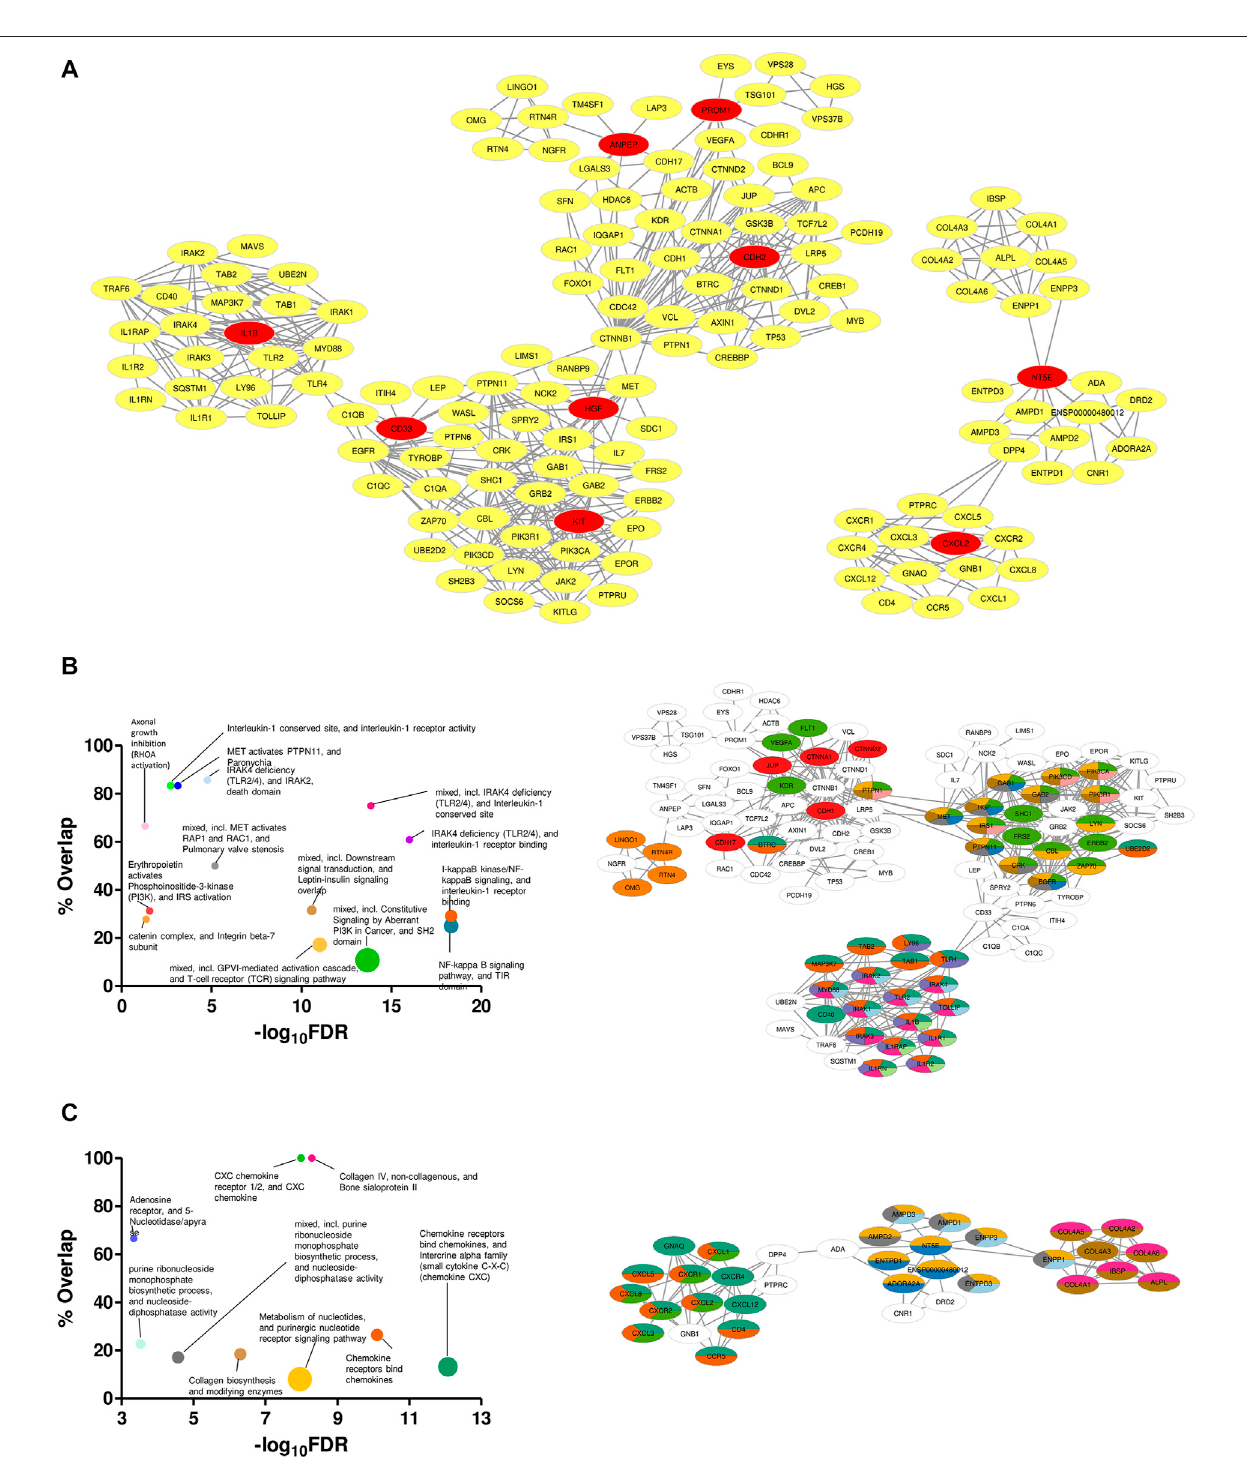
FIGURE 9 | Unique clustering pattern within the interactome of the proposed biomarkers. (A) Merged physical interactome of the proposed biomarkers. The biomarker genes are denoted by red nodes, while the primary and secondary interactors are denoted by yellow nodes. (B,C) Bubble plots ( B , C : left panel) depicting over-represented pathways in the left (B) and right (C) cluster, respectively. Individual pathways were mapped onto the participant genes ( B , C : right panel). Sizes of the bubblesonthebubbleplotsaredirectlyproportionaltothegenesetsizes.Coloursonthepathway-mappednetworksdenoteindividualpathways,ascolour-coded on the corresponding bubble